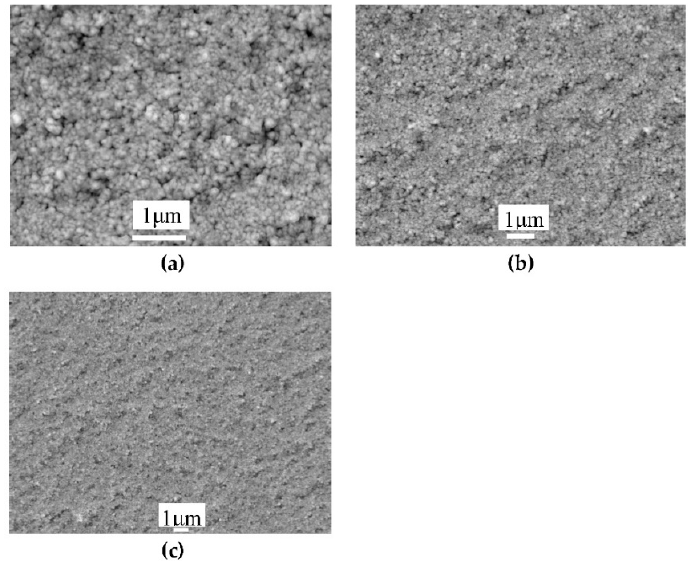
Figure 5. SEM images of a CZTS film deposited from the as-fabricated CZTS nanoparticle inks under different magnifications: ( a ) 20000×; ( b ) 10000×; and ( c ) 5000×.